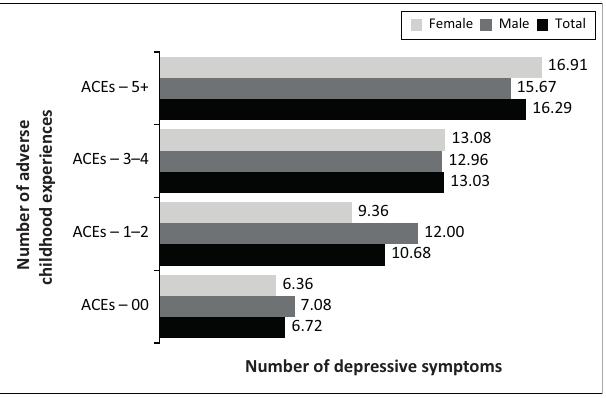
FIGURE 1: Depressive symptoms stratified by the number of adverse childhood